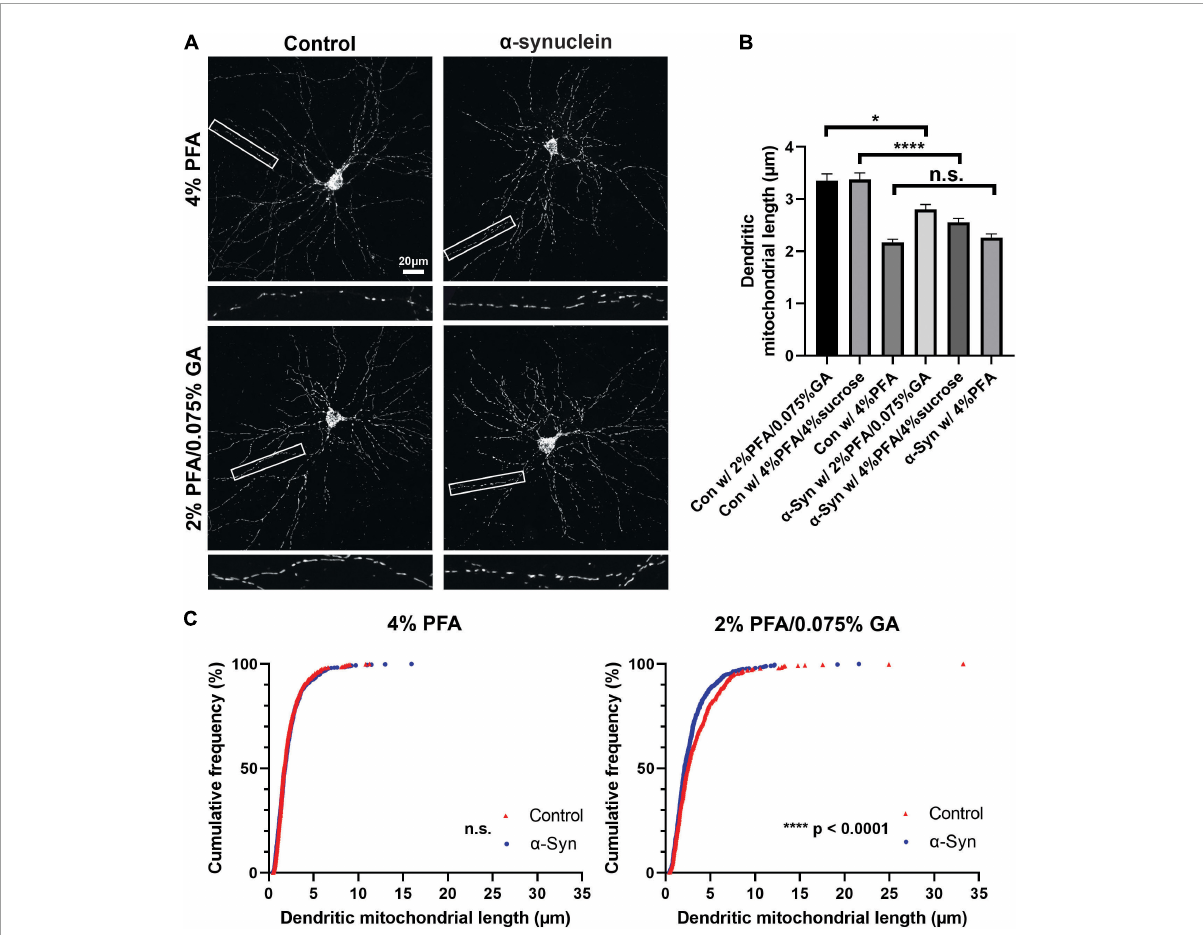
FIGURE5 Fixative affects mitochondrial morphology analysis of a neurodegenerative disease model. (A) Images of control and α -synuclein-treated neurons, which were fixed with three different fixation solutions (4% PFA, 2% PFA/0.075% GA, and 4% PFA/4% sucrose) for 15 min at DIV21. (B) Quantification of dendritic mitochondrial length confirmed 2% PFA/0.075% GA and 4% PFA/4% sucrose fixed samples showed differences between α -synuclein-treated neurons and control neurons. In contrast, there were no differences in 4% PFA fixed samples. n Con w / 4%PFA = 3 cultures, 34 dendrites, 510 mitochondria, n Con w / PFA / GA = 3 cultures, 32 dendrites, 442 mitochondria, n Con w / PFA / sucrose = 3 cultures, 32 dendrites, 625 mitochondria, n α − syn w / 4%PFA = 3 cultures, 32 dendrites, 587 mitochondria, n α − syn w / PFA / GA = 3 cultures, 34 dendrites, 642 mitochondria, and n α − syn w / PFA / sucrose = 3 cultures, 36 dendrites, 629 mitochondria. Kruskal–Wallis test with Dunn’s multiple comparisons test, * p = 0.03 for control vs. α -syn in 2% PFA/0.075% GA, **** p < 0.0001 for control vs. α -syn in 4% PFA/4% sucrose. (C) Cumulative frequencies of dendritic mitochondrial length in 4% PFA showing no differences in dendritic mitochondria. (D) Cumulative frequencies of dendritic mitochondrial length in 2% PFA/0.075% GA